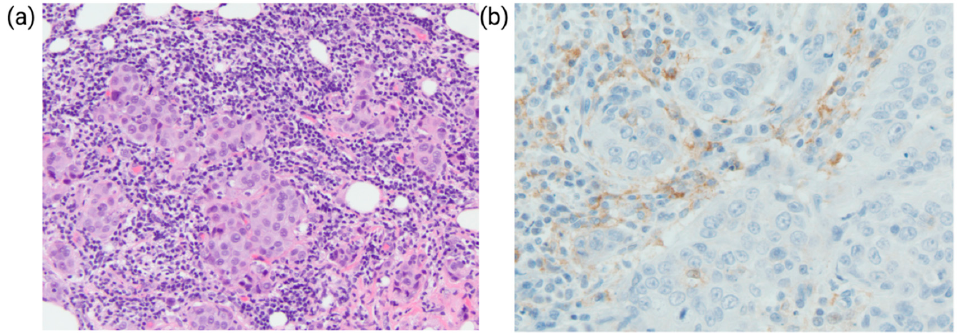
Figure 3. Tumor Infiltrating Lymphocytes and Programmed death ligand 1 (PD-L1) Expression in Breast cancer. ( a ) Invasive ductal carcinoma with dense lymphocytic infiltrate. ( b ) Positive PD-L1 expression in immune cells; tumor cells are